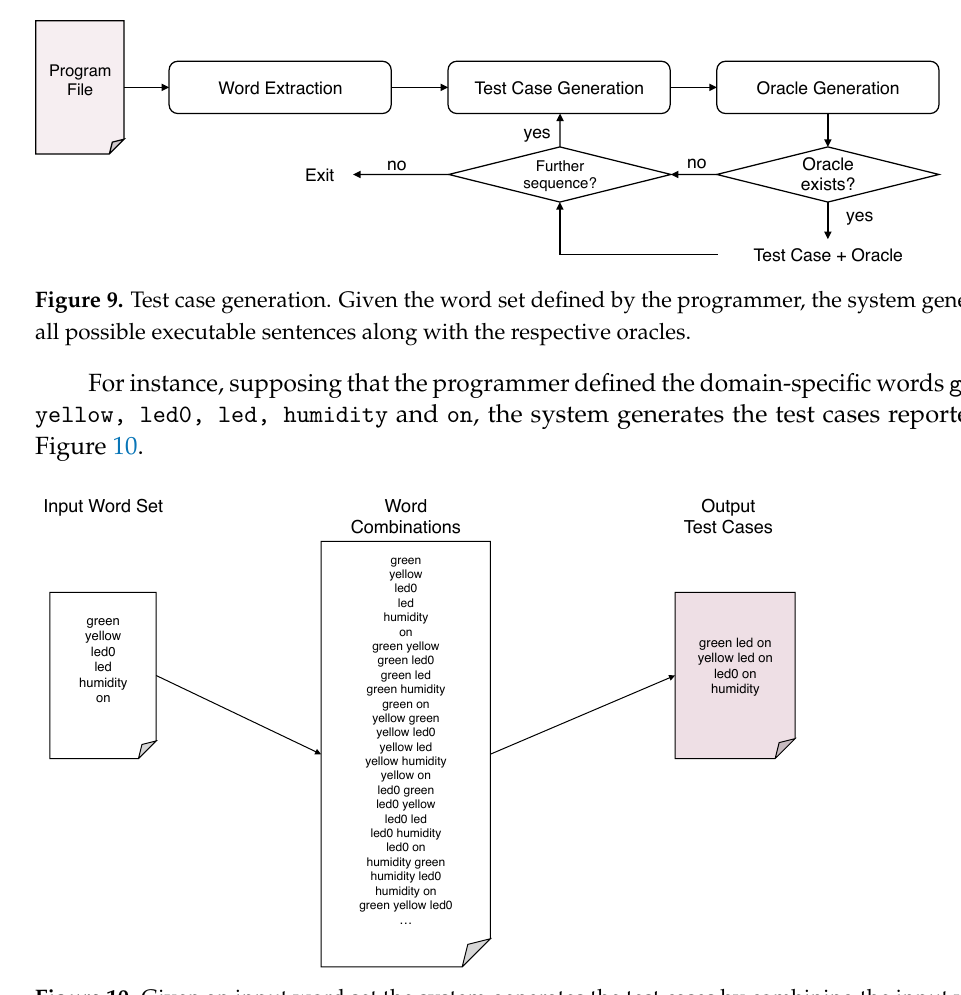
Figure 10. Given an input word set the system generates the test cases by combining the input words into executable